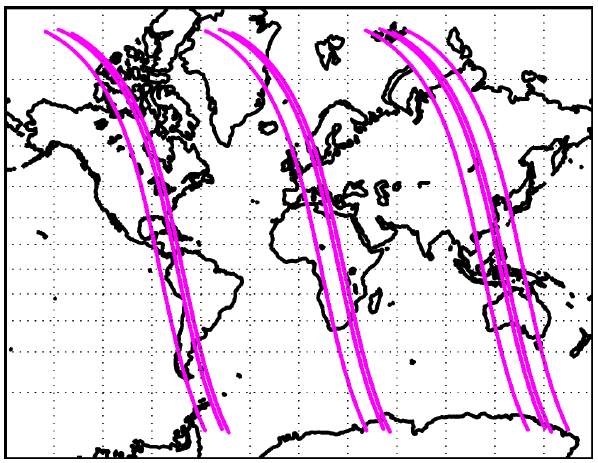
Fig. 5. Polar orbits along which spectra were simulated. Only spec- tra over land were analysed.